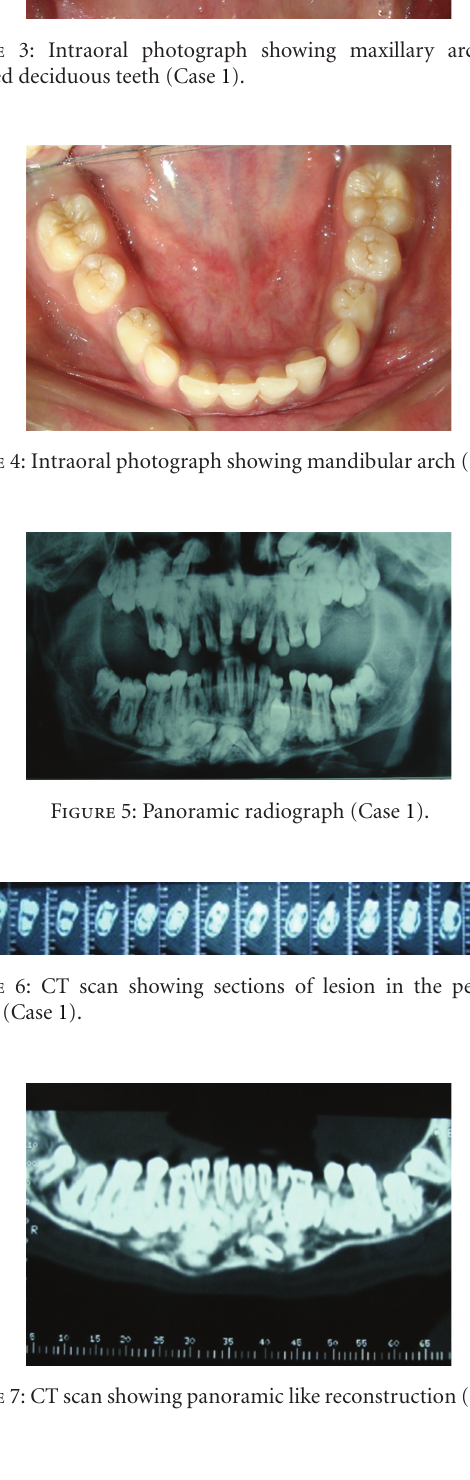
Figure 7: CT scan showing panoramic like reconstruction (Case